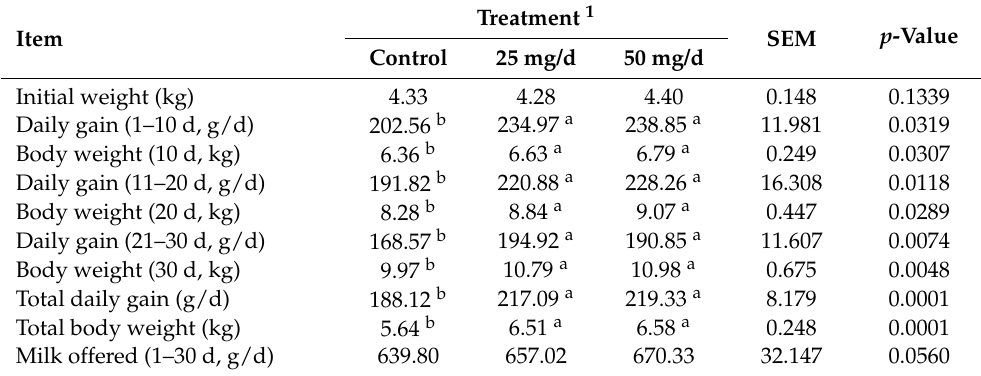
Table 1. The effect of organic iron supplementation on suckling